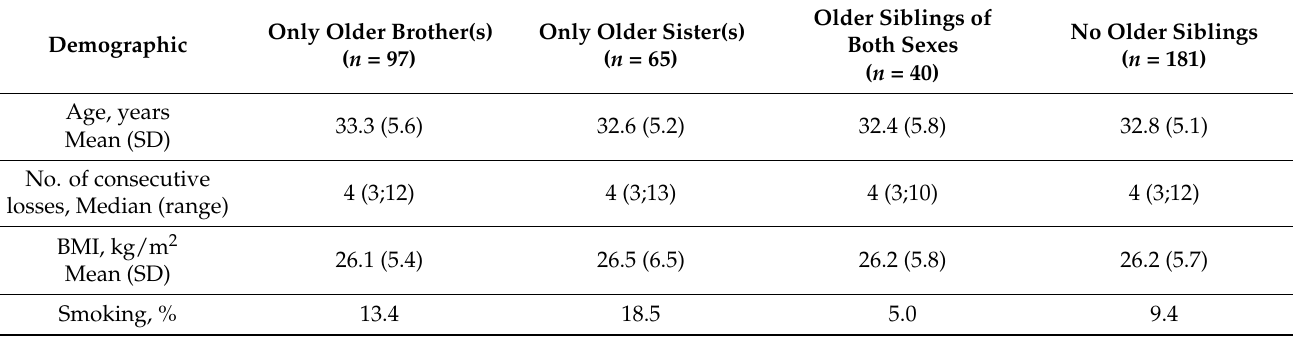
Table 2. Demographic data on recurrent pregnancy loss (RPL) patients stratified according to the sex of older siblings. All demographic data were obtained at time of referral.